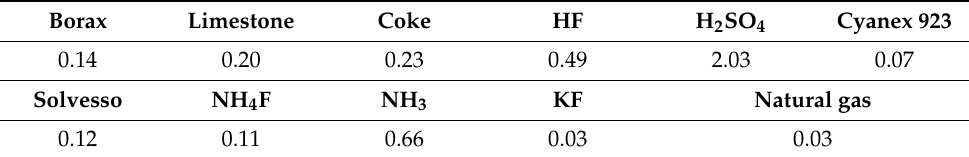
Table 1. Amount of reagents introduced (in